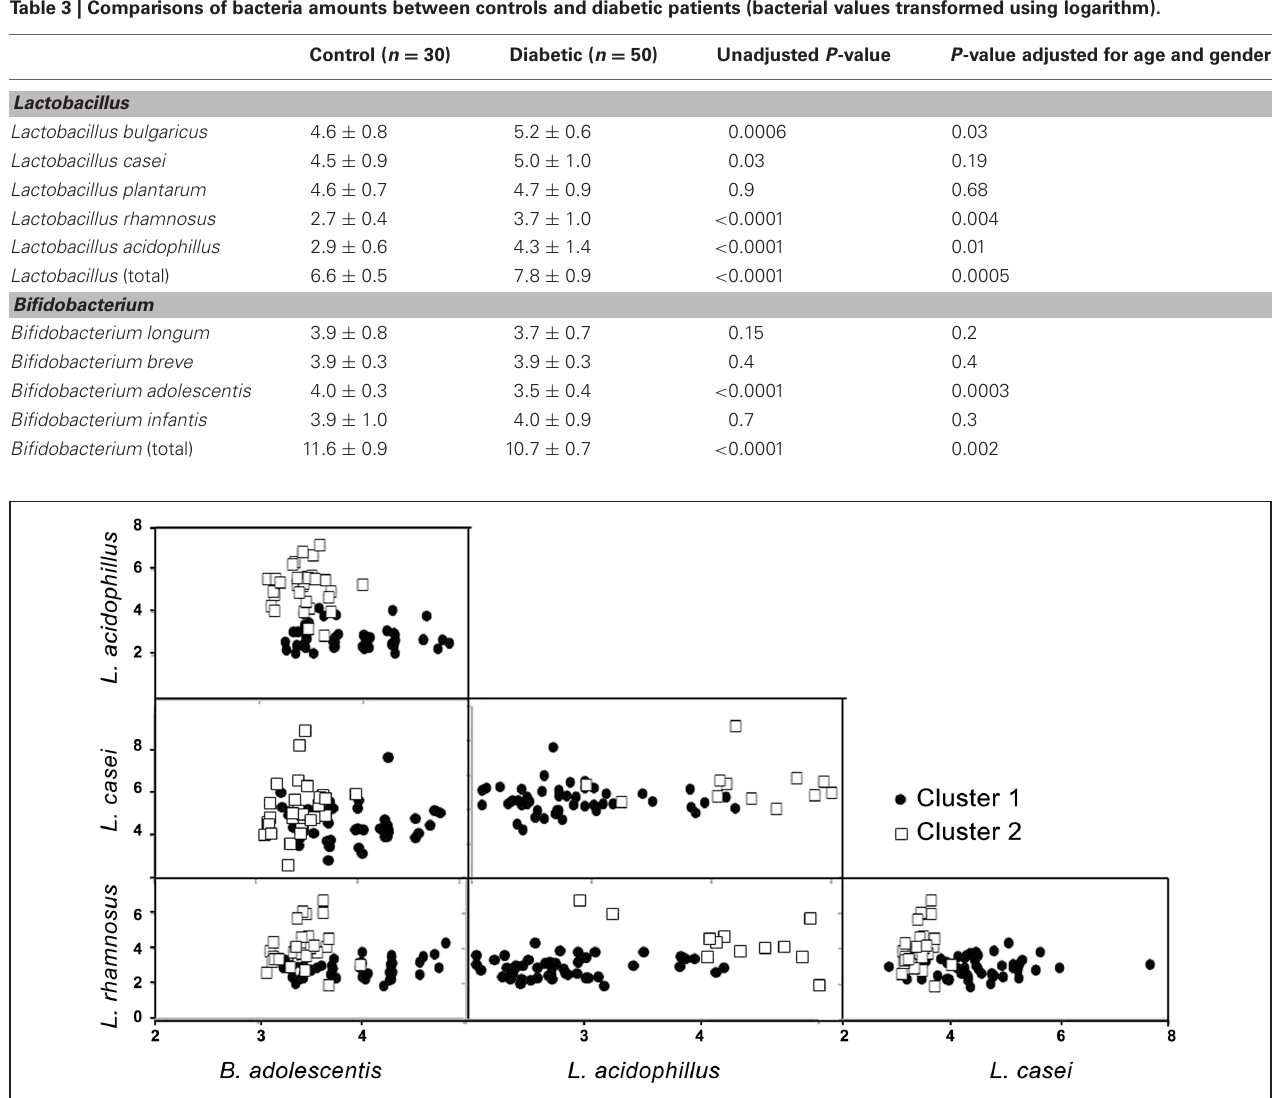
FIGURE 1 | Schematic representation of the two clusters (bacterial values transformed using